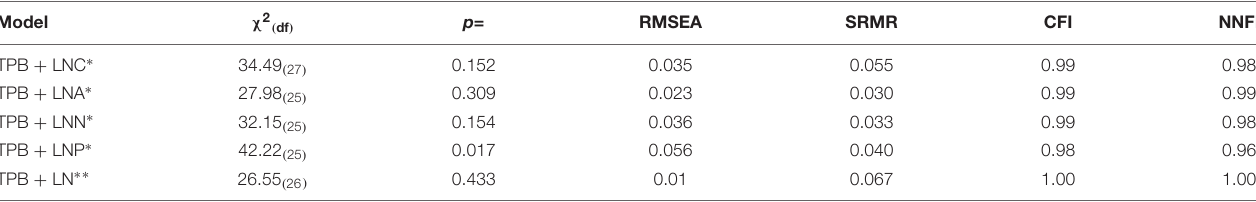
TABLE 1 | Results of the six CFAs assessing the validity of the measures used in all the models tested in the study. Model χ 2 ( df )